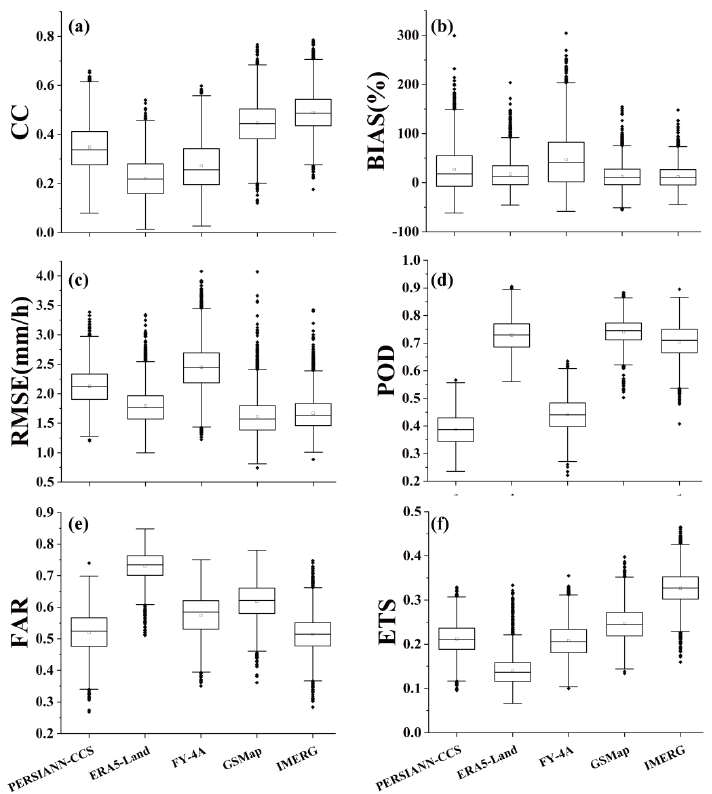
Figure 12. The numerical distributions of contingency statistics for PERSIANN-CCS, ERA5-Land, FY-4A, GSMaP, and IMERG in terms of ( a ) CC, ( b ) BIAS, ( c ) RMSE, ( d ) POD, ( e ) FAR, and ( f ) ETS, respectively. Table 5. Averaged statistical indices for PERSIANN-CCS, ERA5-Land, FY-4A, GSMaP, and IMERG at hourly scale over southern China in summer 2019.